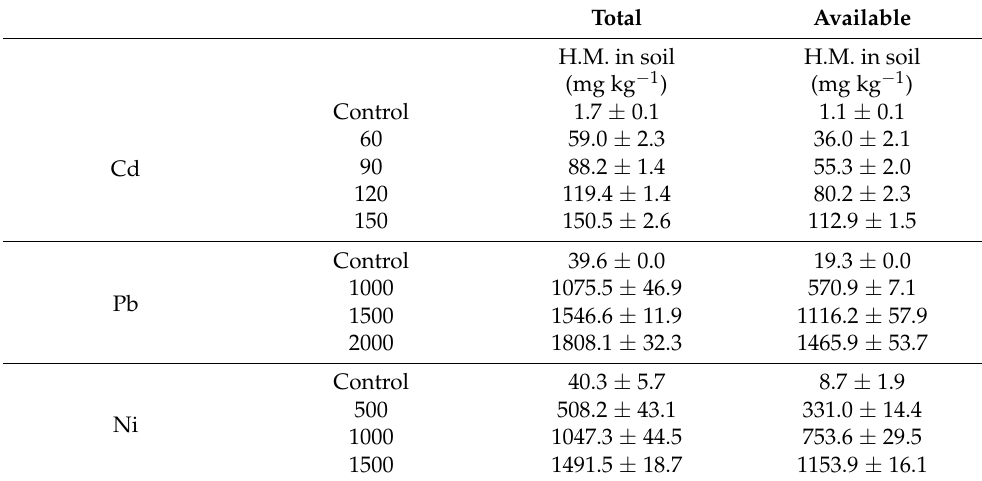
Table 3. Total and available heavy metal (mg kg − 1 ) in the